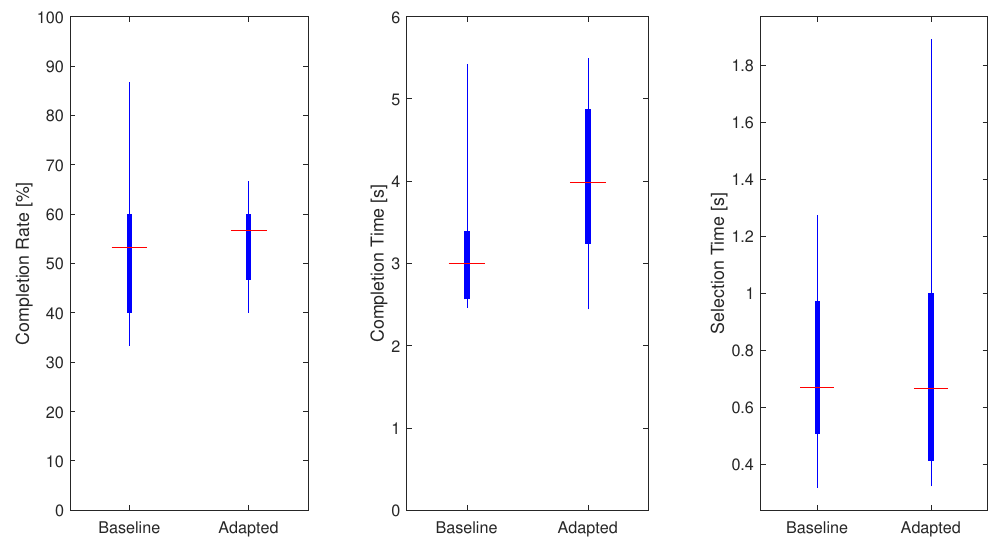
Figure 15. TAC test results summarized for all subjects, hand motions and external loads: completion rate ( left ), completion time ( center ), selection time ( right